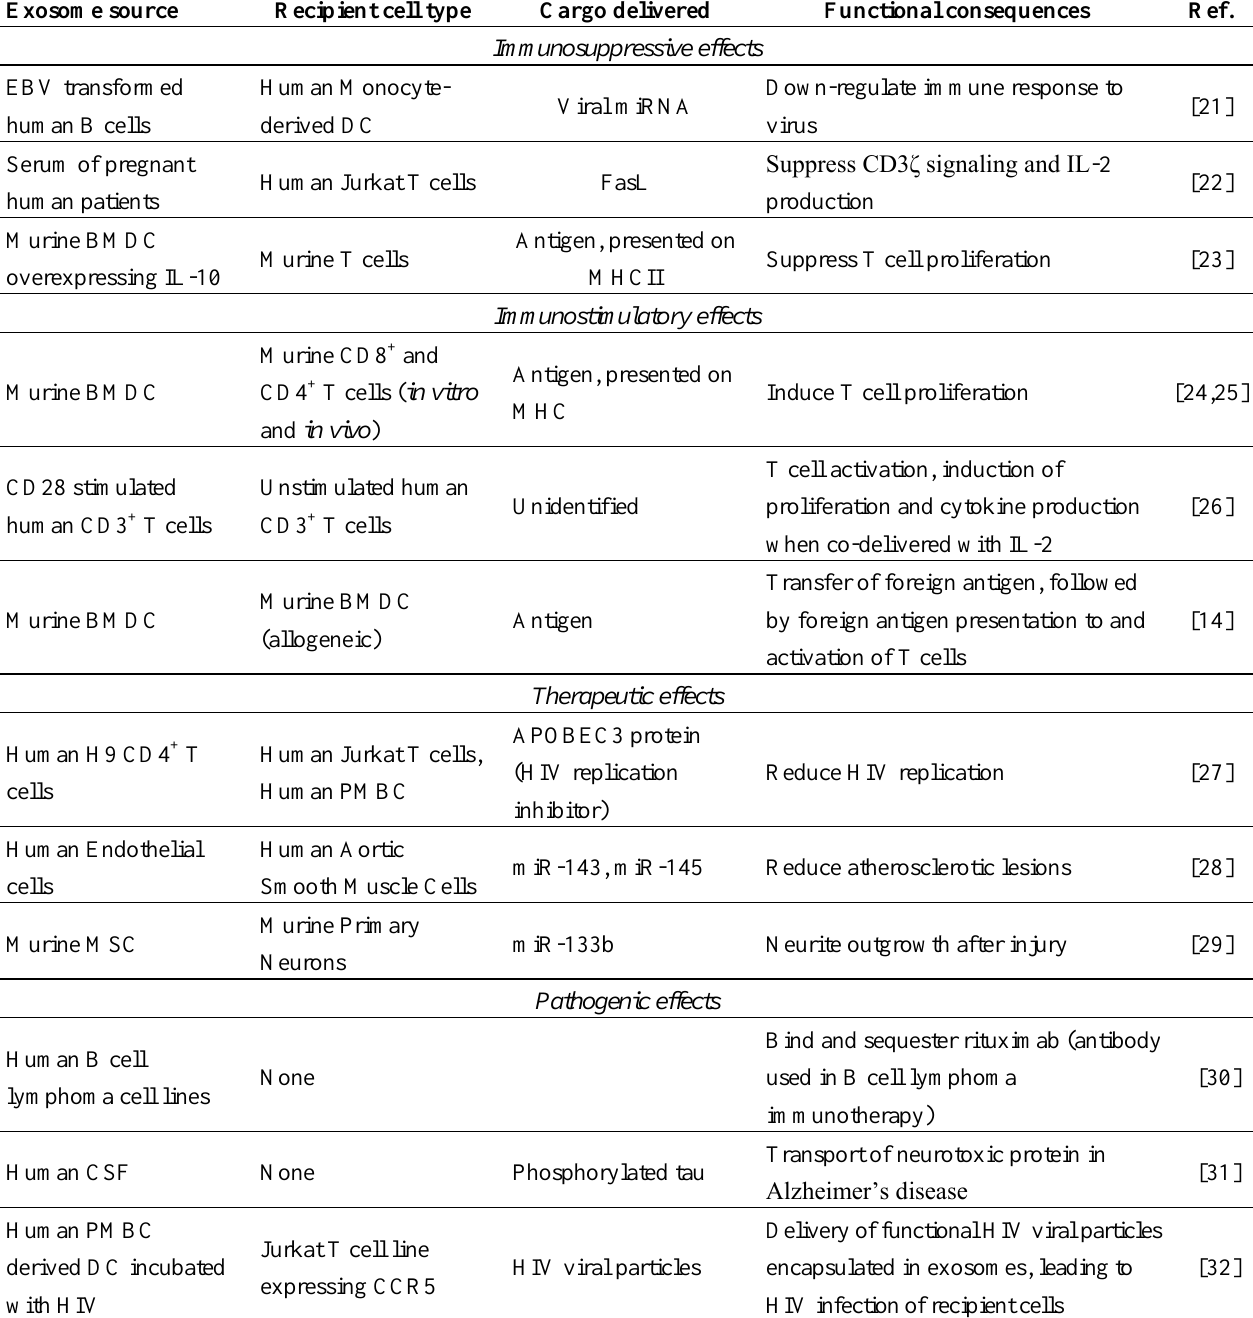
Table 1. Functional consequences of exosome delivery to recipient